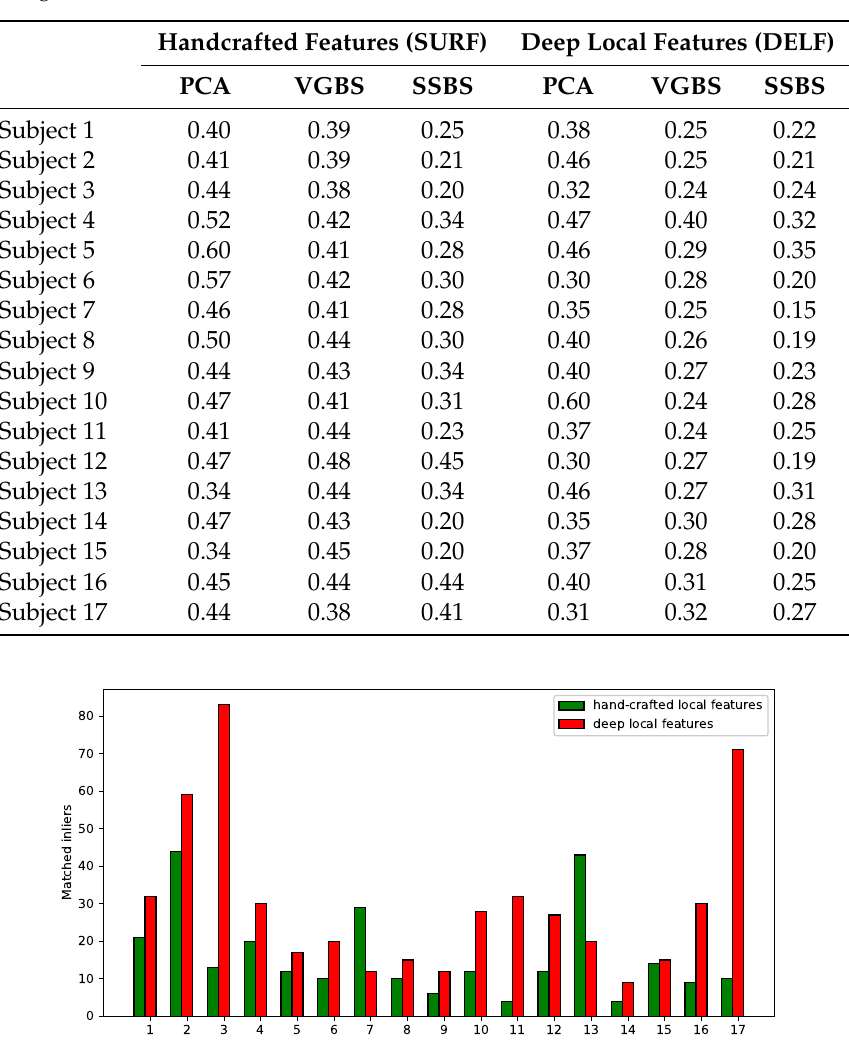
Table 2. Results of the mean error per subject (in mm) in 2D skin feature localization. Handcrafted local features are compared with deep local features when PCA (three principal components) and band selection algorithms are used (10 selected bands).